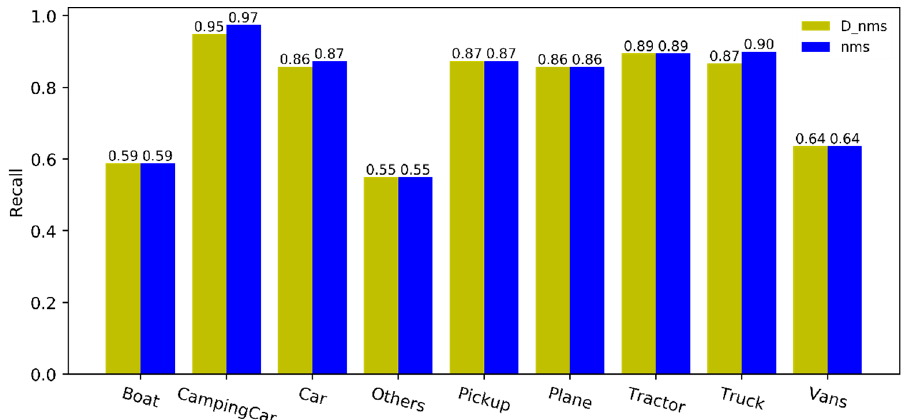
Figure 7. Precision comparison of the detection results after processing by the dual-NMS and NMS, respectively.